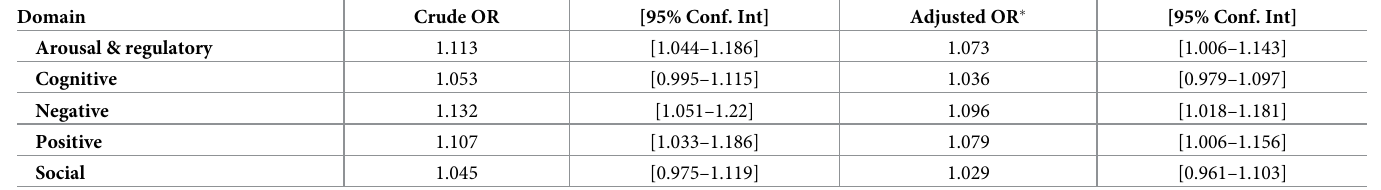
Table 2. Crude and adjusted odds ratios (OR) for 90-day readmission risk, by change in estimated Research Domain Criteria score between admission and discharge. Domain Crude OR [95% Conf. Int] Adjusted OR � [95% Conf.